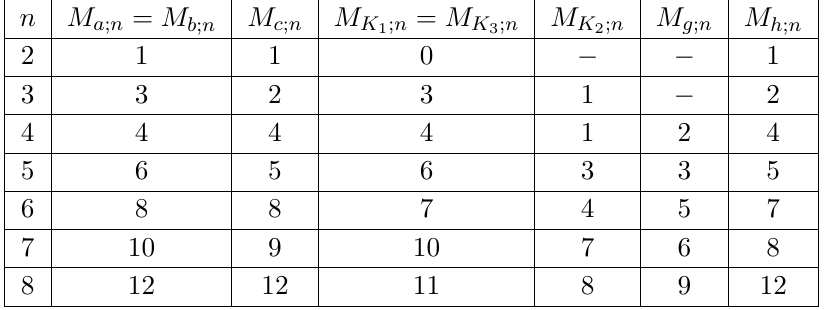
Table 1 . Upper limits of summation in